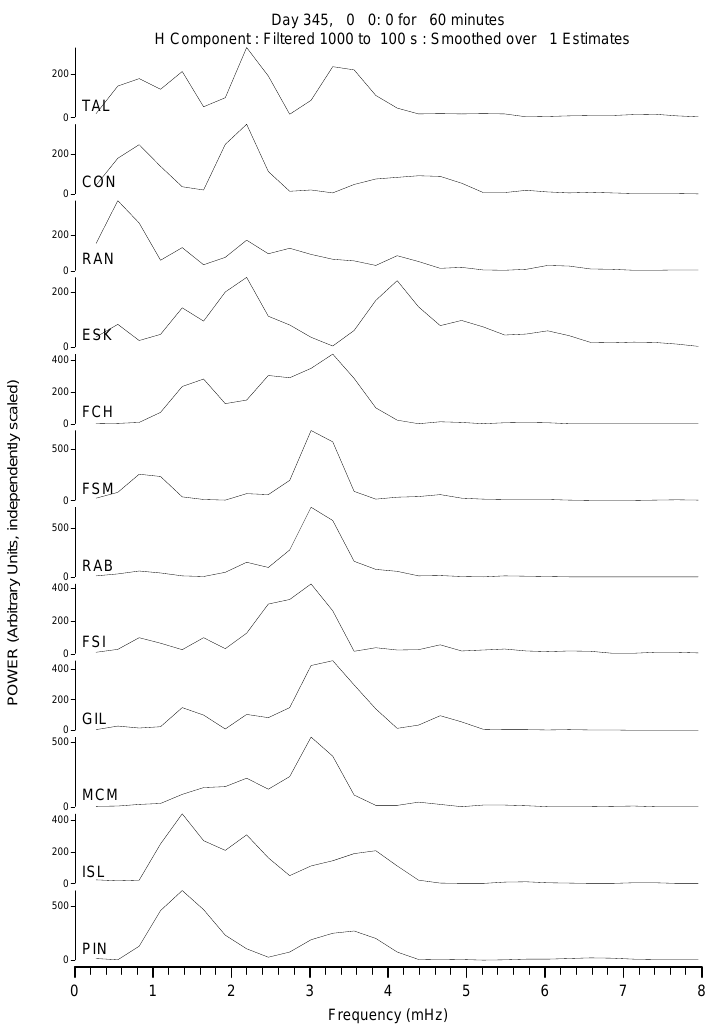
Fig. 3. CANOPUS stacked H -component power spectra (filtered from 1–10mHz) from 00:00UT to 01:00UT on 10 December 2000.